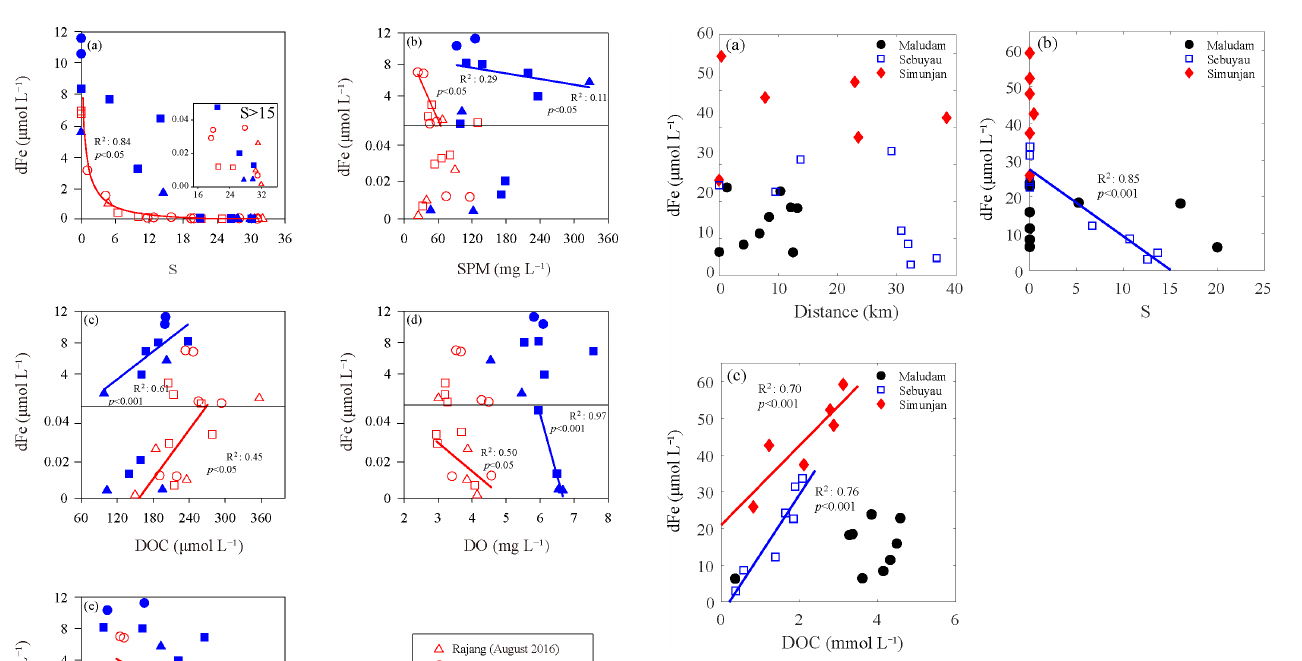
Figure 4. Correlations among the distance (a) , salinity ( S ) (b) , dis- solved organic carbon (DOC) (c) and dissolved iron (dFe) in black- water rivers: Maludam, Sebuyau and Simunjan. The solid lines were the linear regressions between dFe and other factors, and the col- ors of the regression lines were coincident with the data points. We adopted the station at the upper stream as having distance of 0 and the downstream direction as